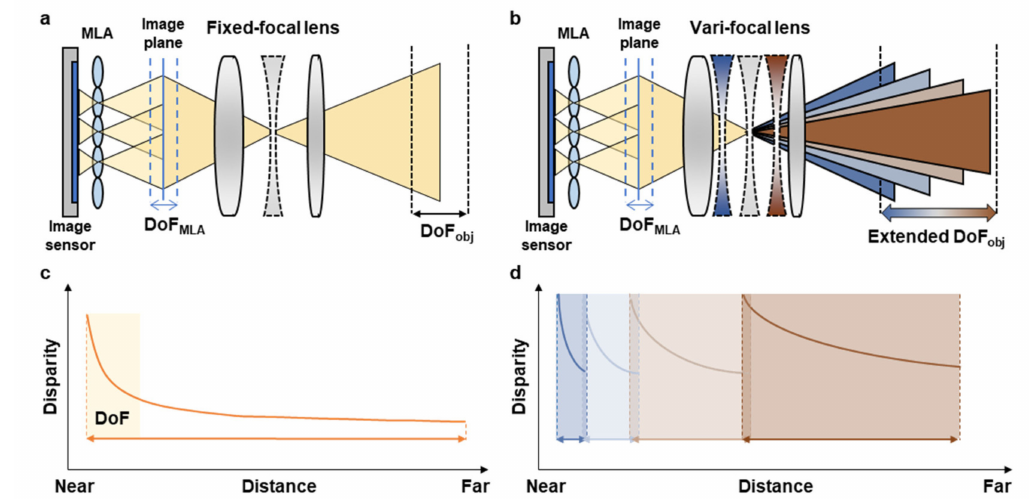
Figure 1. ( a , b ) Schematic of conventional light field camera ( a ) and proposed light field camera with a vari-focal lens ( b ). ( c , d ) Relationship between disparity and object distance. ( c ) The disparity of the conventional light field camera decreases and converges. ( d ) By controlling the focal length before the disparity converges, the proposed VF-LFC provides an extremely extended